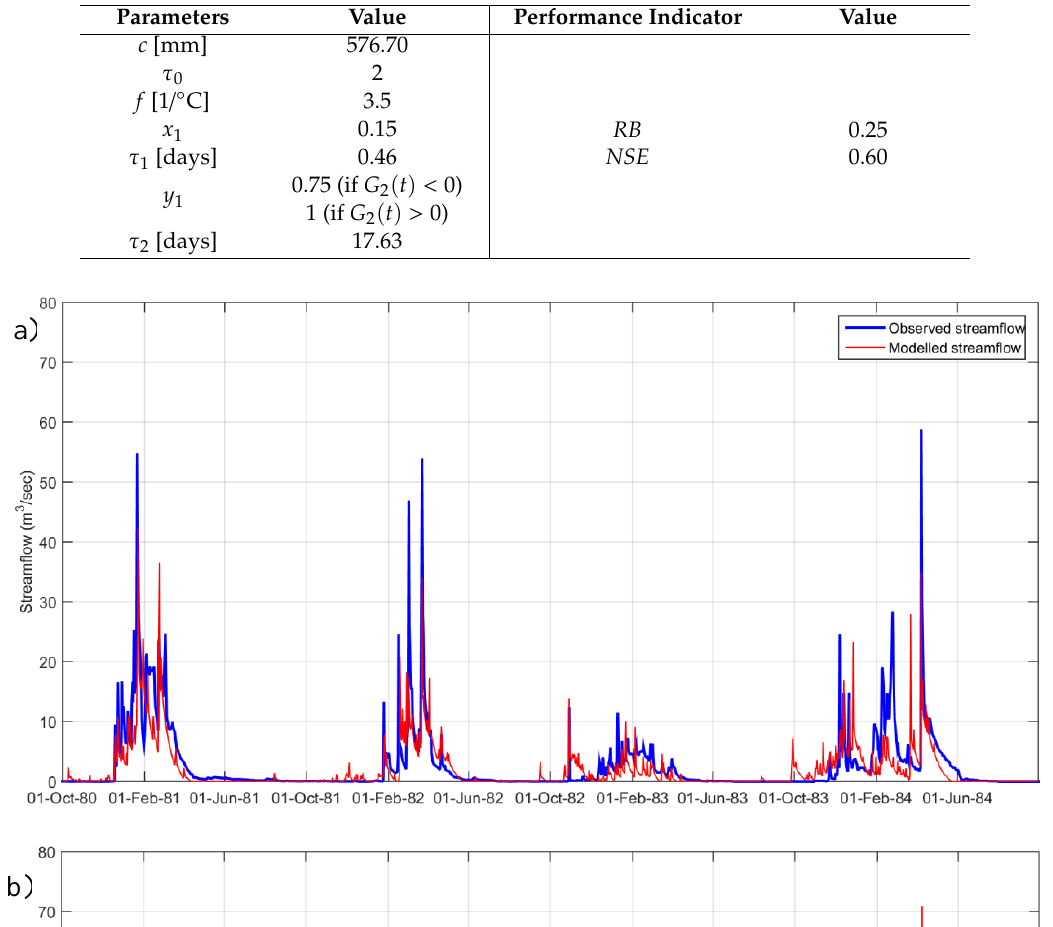
Table 2. Parameter values and performance indicators of the modified IHACRES model for the calibration period (e ff ective rainfall time-series generated from climate by means of the loss module). Parameters Value Performance Indicator